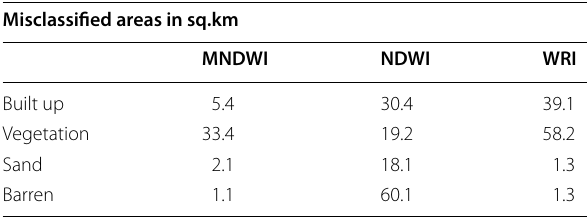
Total areas extracted by SC and Indices